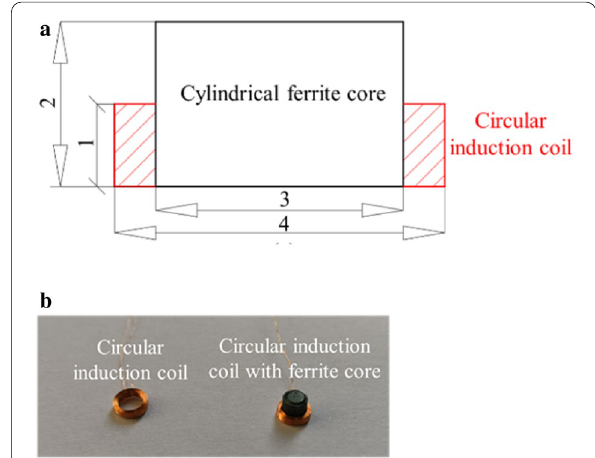
Figure 16 Circular induction coil with ferrite core: ( a ) structure of the proposed sensor; ( b ) picture of the proposed